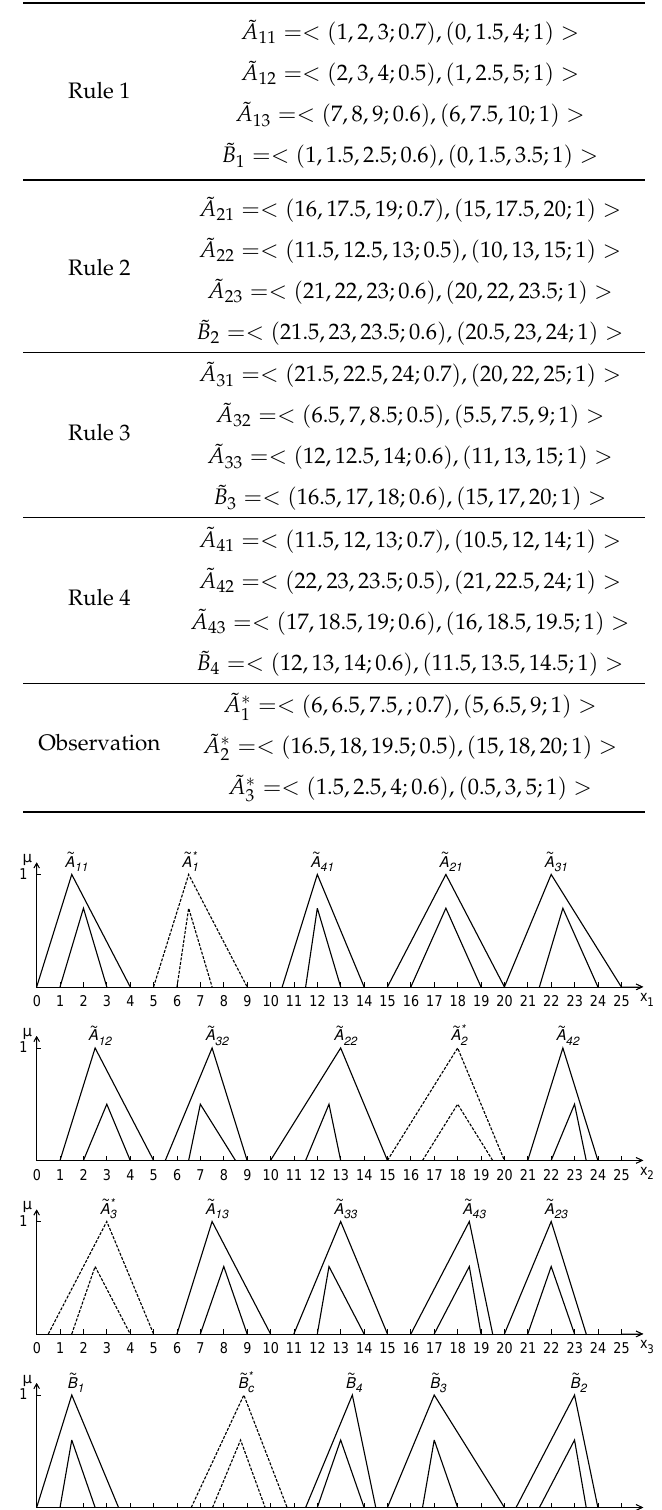
Figure 6. Interpolation and extrapolation involving multiple multi-antecedent rules for Case